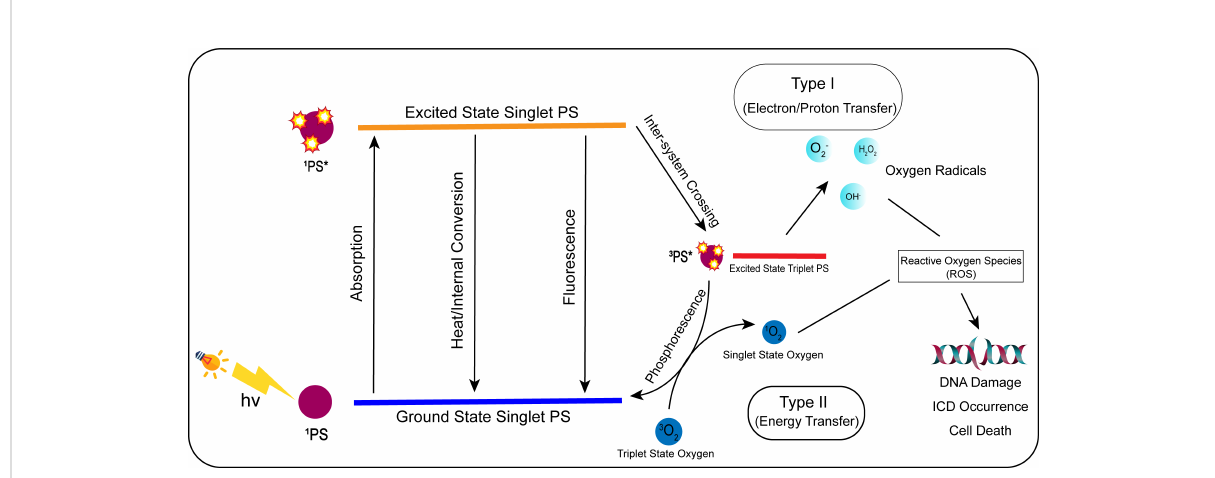
FIGURE 3 Mechanism of action of photodynamic therapy (PDT). In photodynamic treatment, the photosensitizer (PS) converts from a ground state to an excited singlet state by absorbing light energy when exposed to speci fi c light wavelengths. The PS in the excited singlet state is unstable, and its energy is internally converted, lost as thermal energy, or radiated as fl uorescence. The PS in the excited singlet state will reach the excited triplet state by inter-system crossing. The PS in the excited triplet state can be transformed into the ground singlet state through phosphorescence. In type I, the excited triplet state can generate oxygen radicals such as H 2 O 2 , OH - , and O 2 - through electron/proton transfer. In type II, the excited triplet PS can convert 3 O 2 to singlet oxygen ( 1 O 2 ) by energy transfer. H 2 O 2 , OH-, O 2 -, and 1 O 2 are all reactive oxygen species, which can induce ICD reaction, DNA damage, and ultimately tumor cell death when acting on tumor